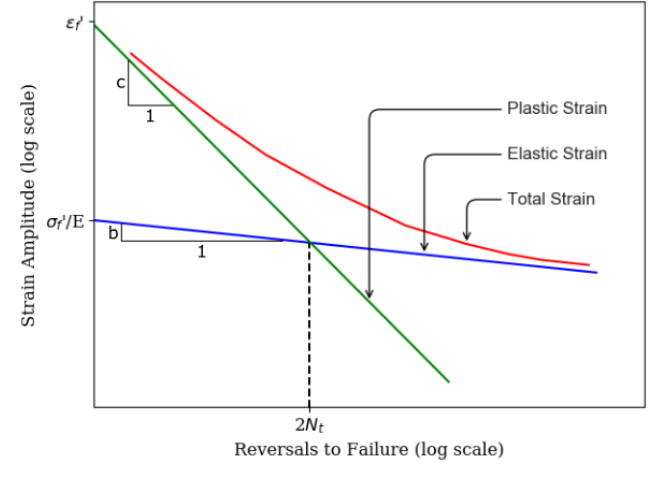
Figure 3b: A typical strain life curve